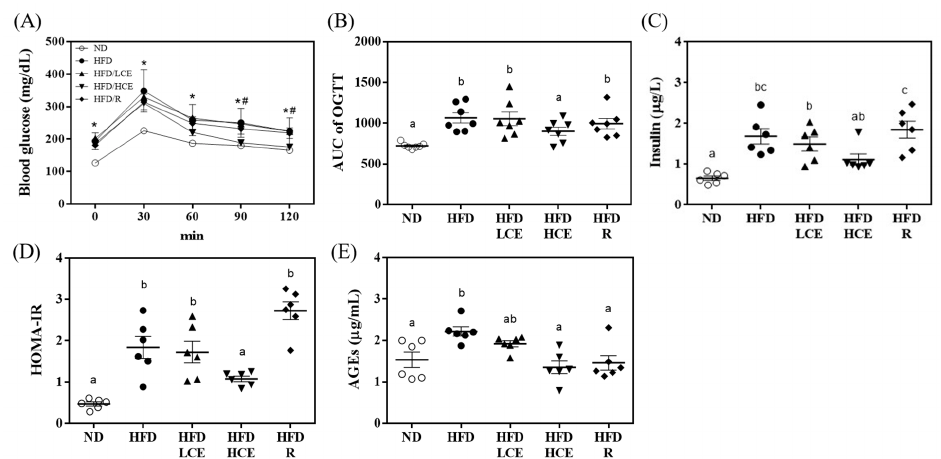
Figure 3. Effects of djulis hull crude extract and rutin on glucose homeostasis and advanced glycation end products (AGEs) in high-fat diet-induced hyperglycaemia. ( A ) Blood glucose was measured every 30 min over 2 h after an oral glucose load. ( B ) AUC of the oral glucose tolerance test (OGTT). ( C ) Insulin. ( D ) Homeostasis model assessment (HOMA-IR). ( E ) AGEs. ND: normal diet; HFD: high-fat diet; LCE: low dosage of crude extract; HCE: high dosage of crude extract; R: rutin; AUC: area under the curve; HOMA-IR = (glucose (mg/dL) × insulin (mIU/L))/405. Values represent the mean ± SEM ( n = 6). The statistical methods used one-way ANOVA, and the values with different superscript letters are significantly different at p < 0.05. * p < 0.05 ND vs. HFD; # p < 0.05 HFD vs. HFD/HCE.